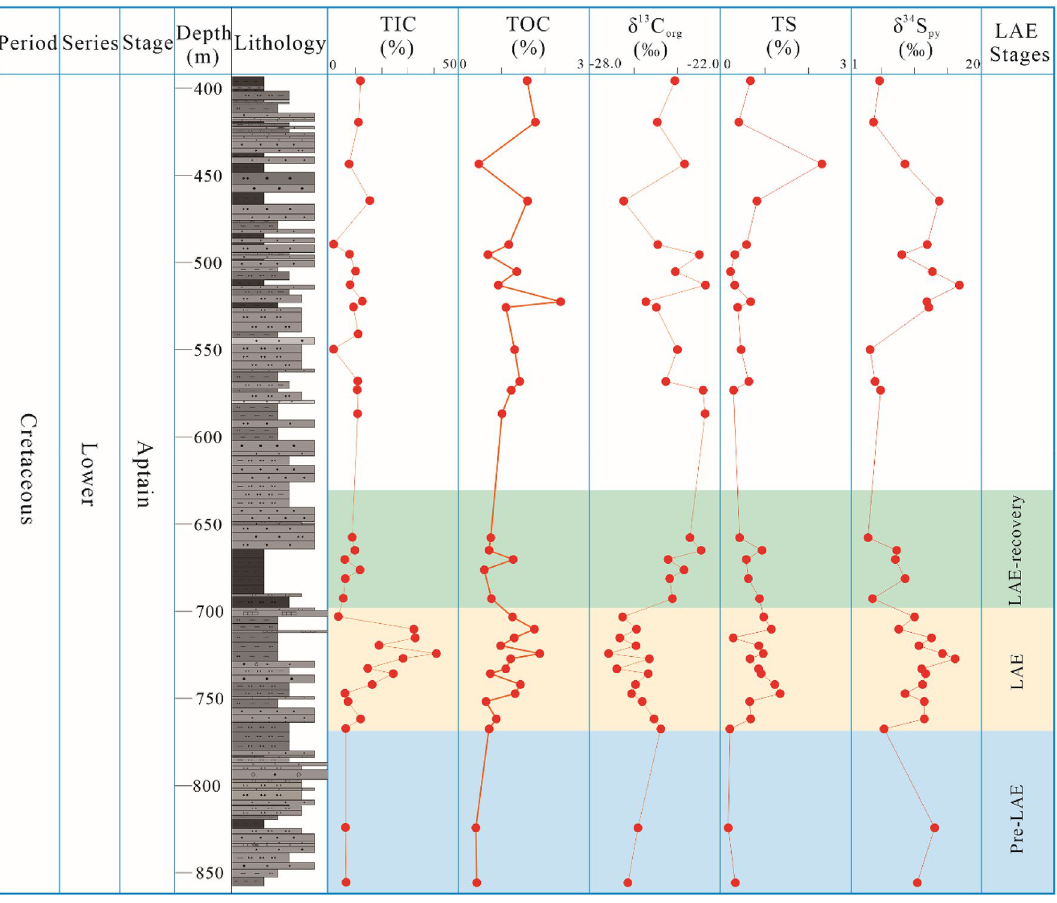
Figure 3. Composite stratigraphic column and vertical variations total inorganic carbon (TIC), total organic carbon (TOC), stable carbon isotope(δ 13 C org ), total sulfur (TS), and pyrite sulfur isotopes (δ 34 S py ) of the Xiahuapidianzi Formation mudstones. The stages division of lacustrine anoxia events (LAE) according to obvious stage variation of isotope, lithology and lithofacies distribution and changes, and changes in trace elements. (This figure was drawn by CorelDRAW Graphics Suite 2019, vision number: 21.3.0.755, url: https:// www. corel. com/